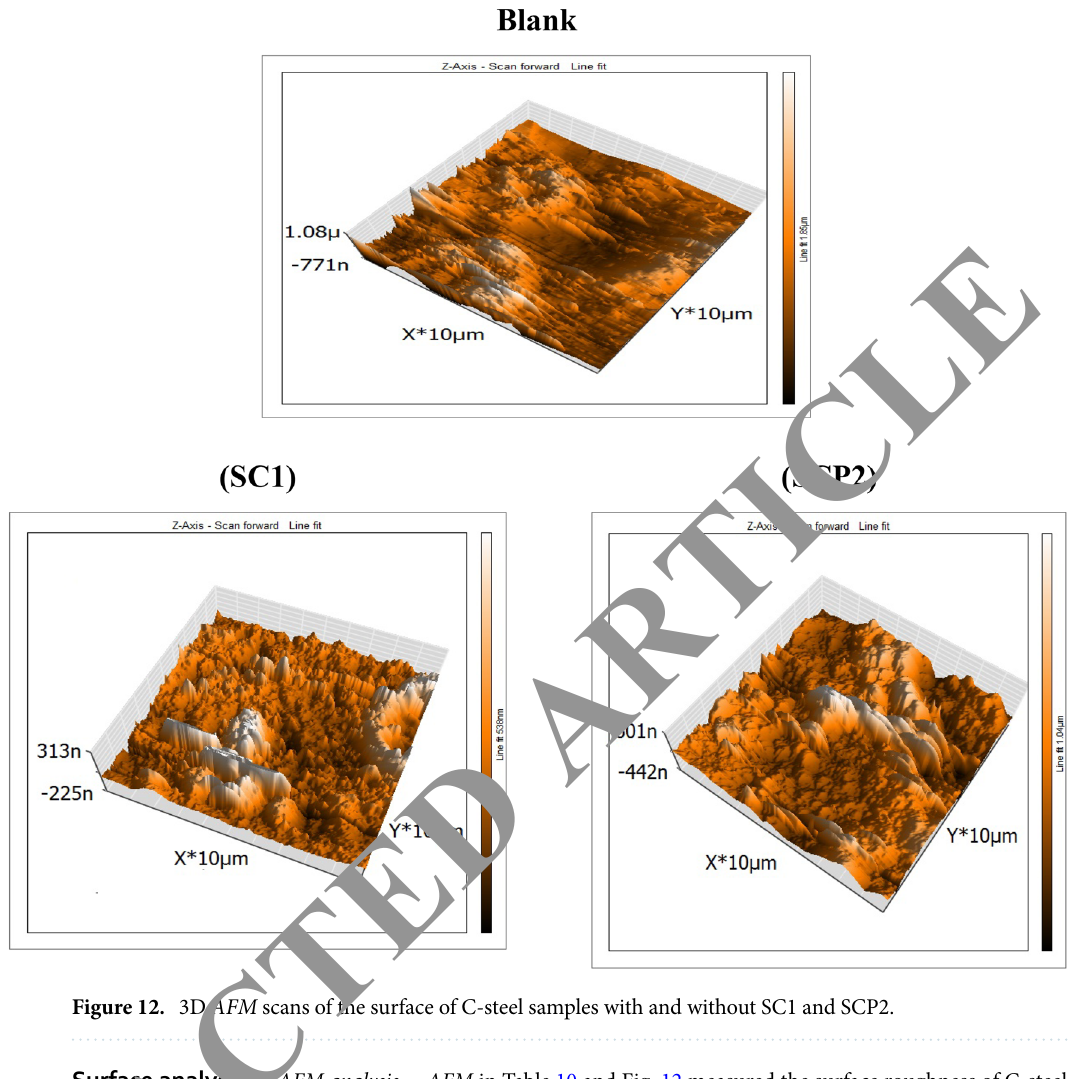
Figure 12. 3D AFM scans of the surface of C-steel samples with and without SC1 and